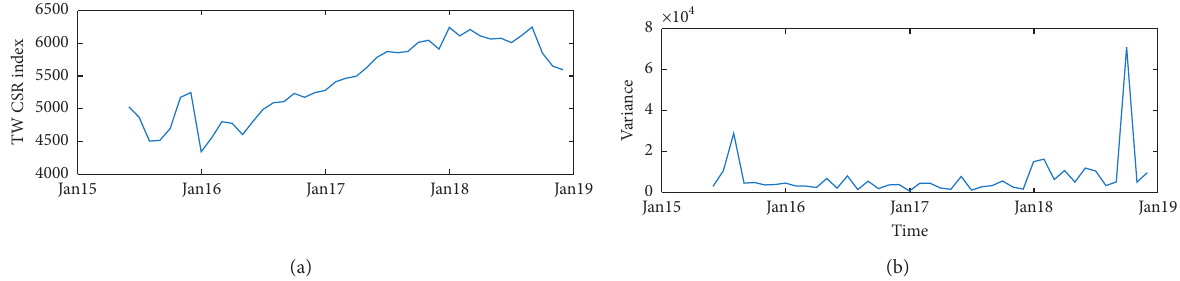
Figure 2: (a) Monthly mean of Taiwan CSR index; (b) monthly variance of Taiwan CSR index.